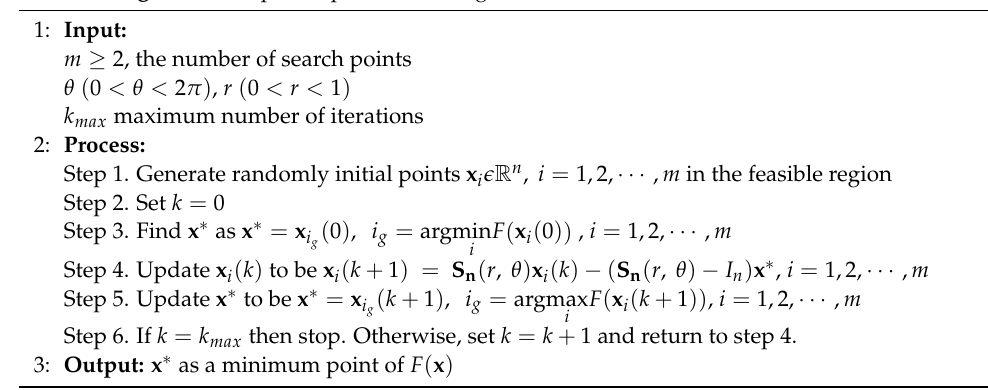
Algorithm 1. Spiral Optimization